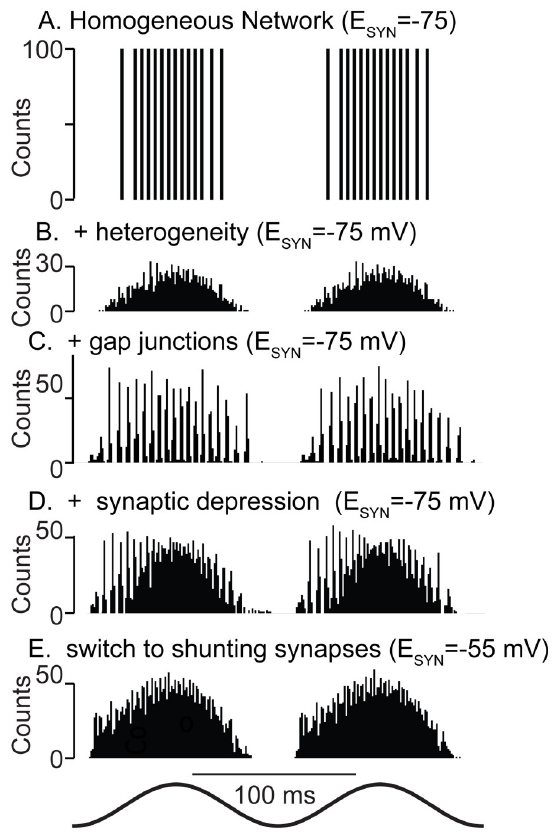
Fig 9. Summary Figure. A. Theta drive (bottom trace) synchronizes homogeneous networks provided there is a minimum conduction delay. B . Full heterogeneity disrupts synchrony. C . Adding physiological levels of gap junctions restores synchrony. D . As hyperpolarizing synapses depress during the theta cycle, synchrony is lost. E . Shunting synapses do not synchronize the fully heterogeneous system even at early phases in the presence of synaptic depression and gap